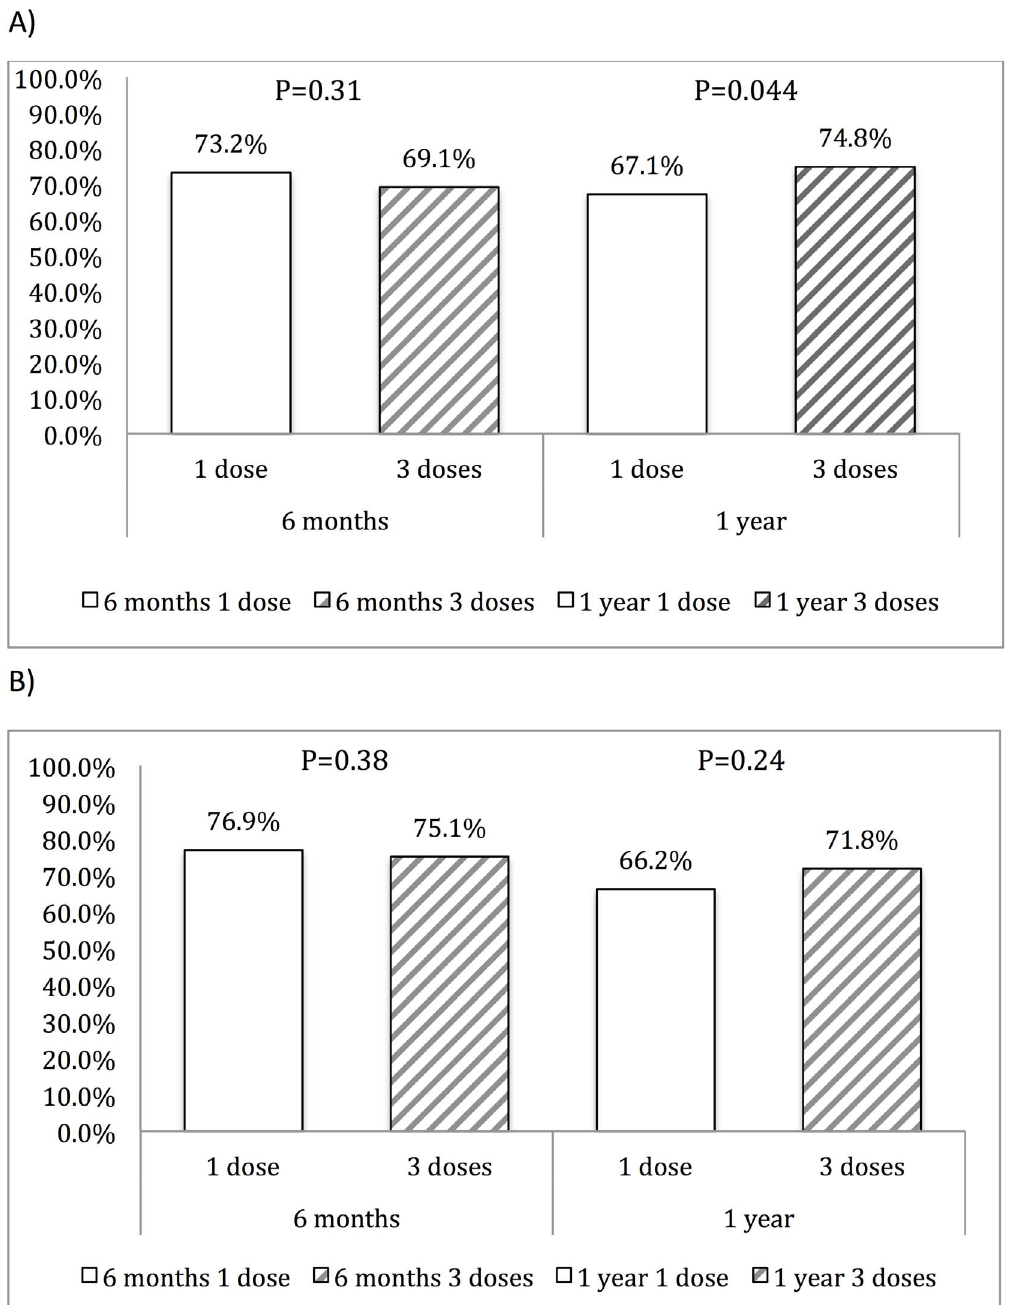
Figure 2. Serological response rates in the 1-dose and 3-dose benzathine penicillin G groups at 6 months and 12 months of follow up. A). Last-observed-carried-forward analysis; B). Per-protocol